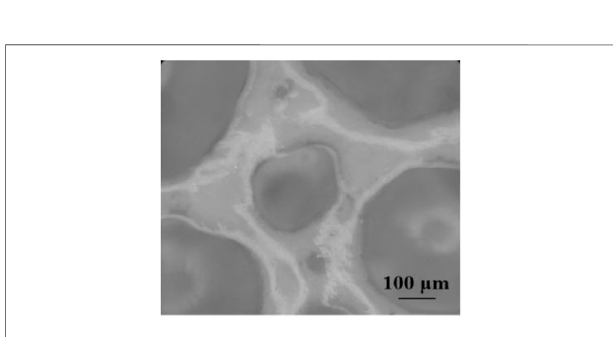
FIGURE 7 | Optical microscopic image of talcum powder in fi